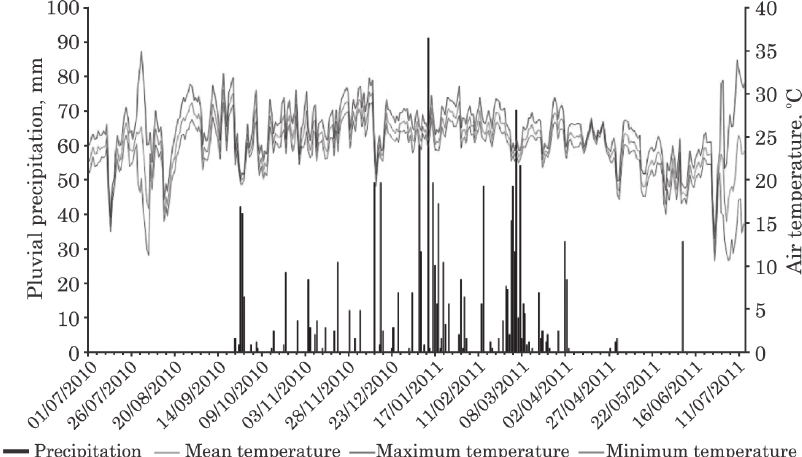
Figure 1. Rainfall and thermal means, obtained in the experimental area from July 2010 to July 2011.